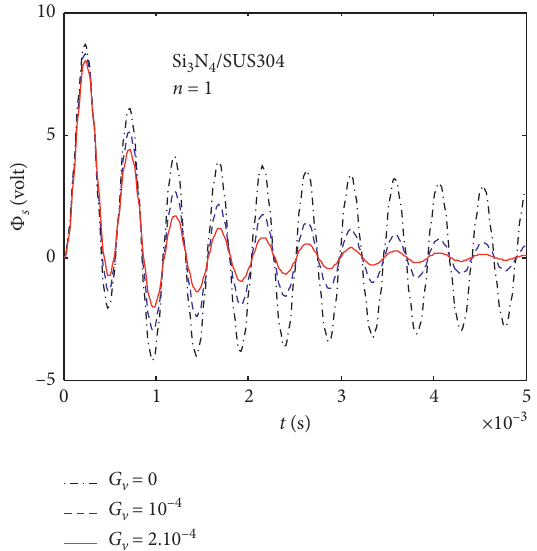
Figure 5: The dependence of ϕ